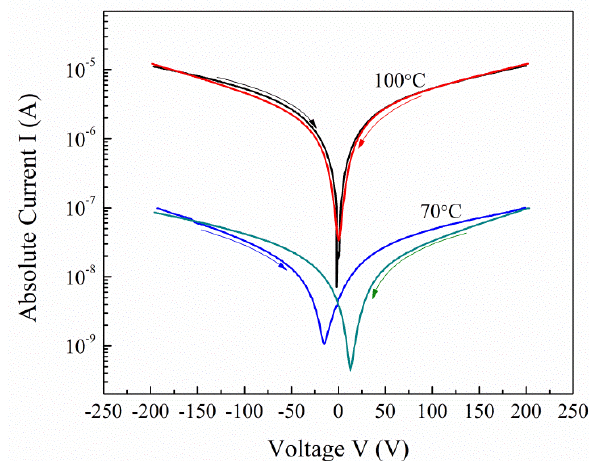
Figure 4: I-V Characteristic curves for S2 and S3 nanocomposites at 60 ∘ C and 90 ∘ C